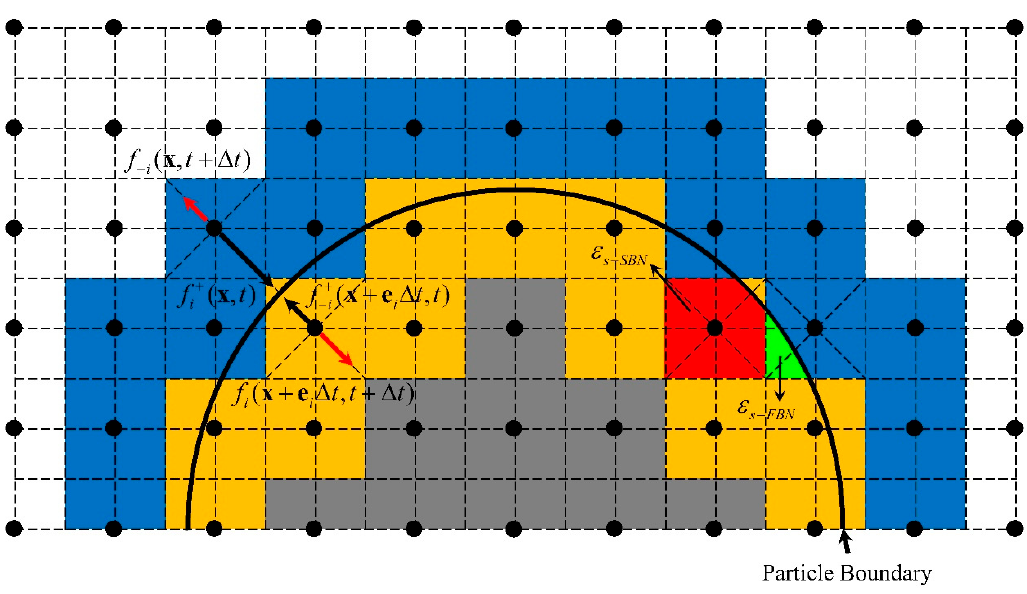
Figure 3. The mapping of a circular solid particle on the lattice grid, showing solid boundary nodes ( orange ), fluid boundary nodes ( blue ), internal solid nodes ( grey ) and pure fluid node ( white ).